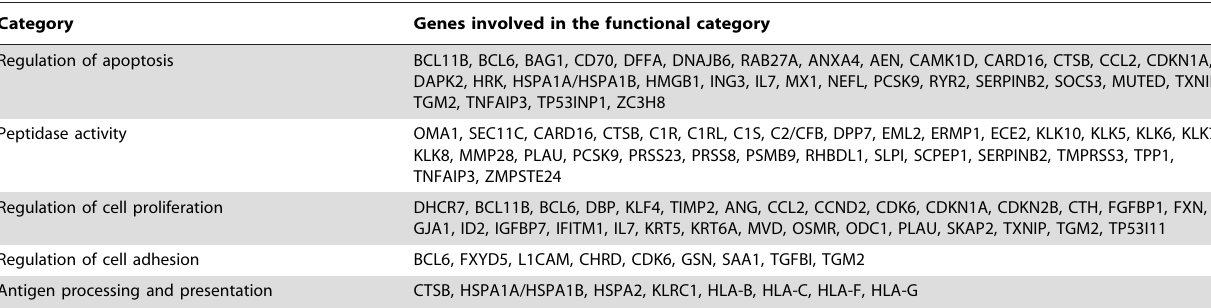
Table 2. List of genes involved in the indicated functional category from table